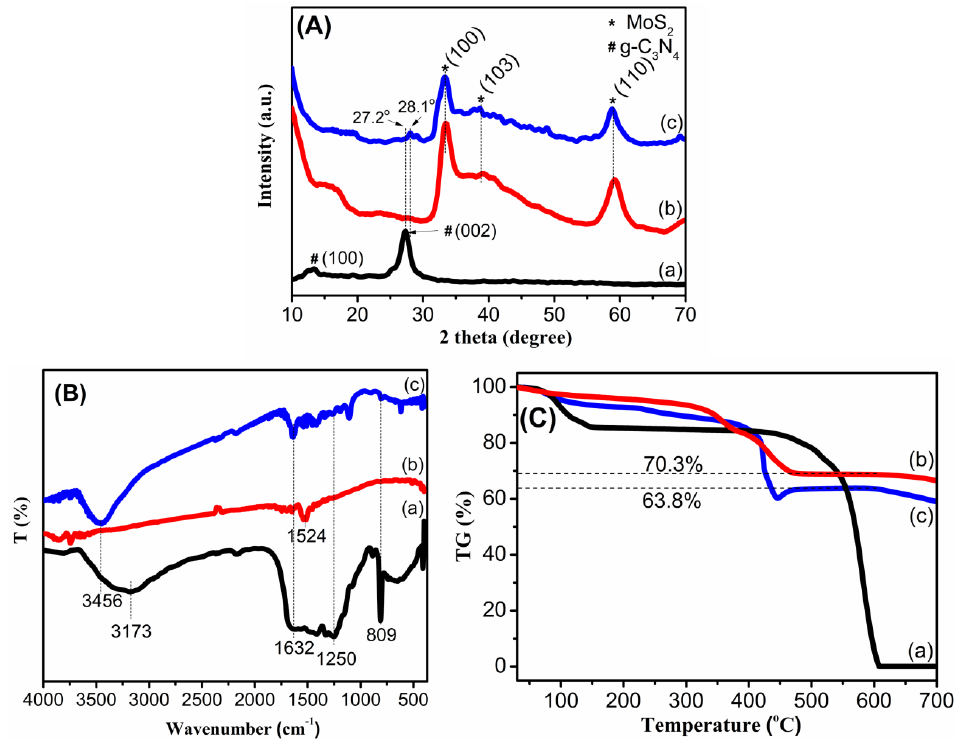
Figure 1. ( A ): XRD patterns of (a) CN, (b) MS and (c) MS/CN; ( B ): IR spectra of (a) CN, (b) MS and (c) MS/CN (c); ( C ) TGA curves of (a) CN, (b) MS and (c)